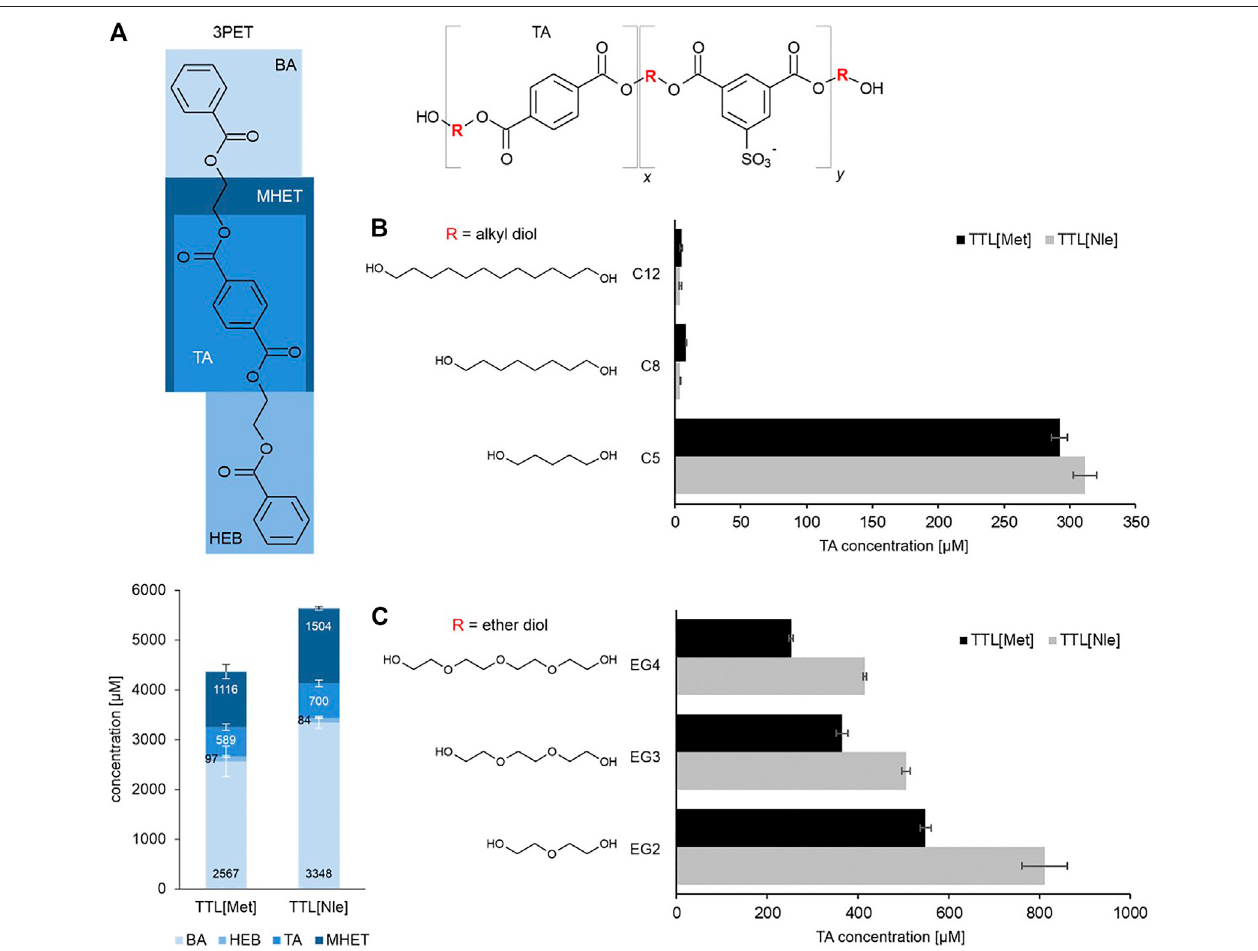
FIGURE 1 | Hydrolysis of polyester model substrates (A) Hydrolysis of the oligomeric model substrate bis-(benzoyloxyethyl) terephthalate (3PET) with 0.6 µM TTL [Nle] and TTL [Met] at pH 7.0. Total released molecules after 24 h of incubation at 70 ° C. The release products BA, benzoic acid; HEB, hydroxyethylbenzoate; TA, terephthalicacidand MHET,Mono-(2-hydroxyethyl)terephthalic acidwerequanti fi edbyHPLC analysis.Each barrepresentstheaverageofthreeindependentsamples; error bars indicate the standard deviation. Hydrolysis of polyesters consisting of 70 mol% terephthalic acid (Ta) and 30 mol% 5-sulfoisophthalic acid (NaSIP) and the respective alkyl and ether diols with different chain lengths of (B) alkyl diols (C5, C8, and C12) and (C) ether diols (EG2, EG3, and EG4). Results obtained from hydrolysis with 1 μ M TTL [Nle] and TTL [Met] at 70 ° C represented as the release of terephthalic acid after 24 h of incubation. Each bar represents the average of three independent samples; error bars indicate the standard deviation. Two-tailed p-values from unpaired t-tests were 0.047 (C5), < 0.001 (C8), 0.40 (C12), 0.001 (EG2), < 0.001 (EG3) and < 0.001 (EG4). Abbreviations: 1,5-pentanediol (C5), 1,8-octanediol (C8), 1,12-dodecanediol (C12) and ether diols with different chain lengths: EG1: ethylene glycol, EG2: diethylene glycol, EG3: triethylene glycol and EG4: tetraethylene